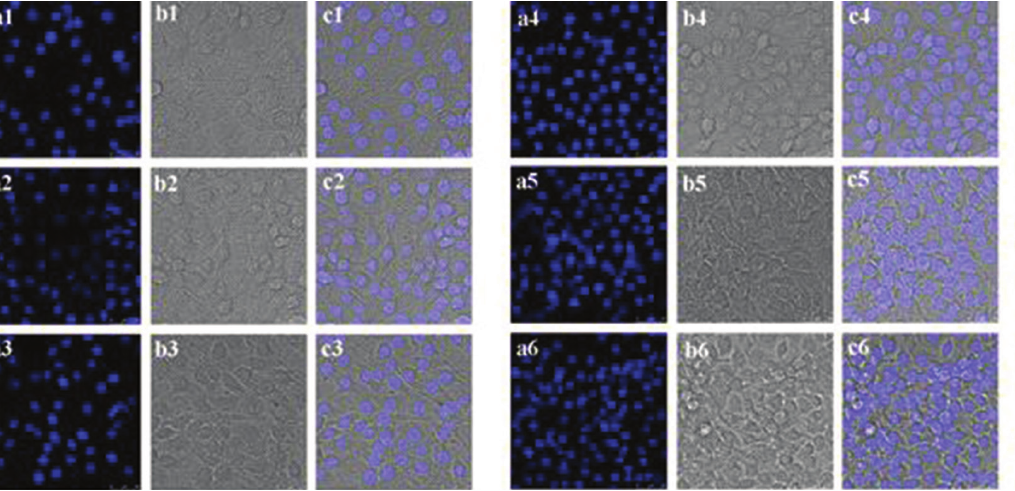
Figure 7: The fluorescent images of cells incubated on the PET/ZnO/TTCP/Gel woven nets for 1 day (a1,b1,c1), 2 day (a2,b2,a2), 3 day (a3,b3,c3), 4 day (a4,b4,c4), 5 day (a5,b5,c5) and 6 day (a6,b6,c6) under the identical instrumental conditions at 100× magnification and are presented at the same intensity